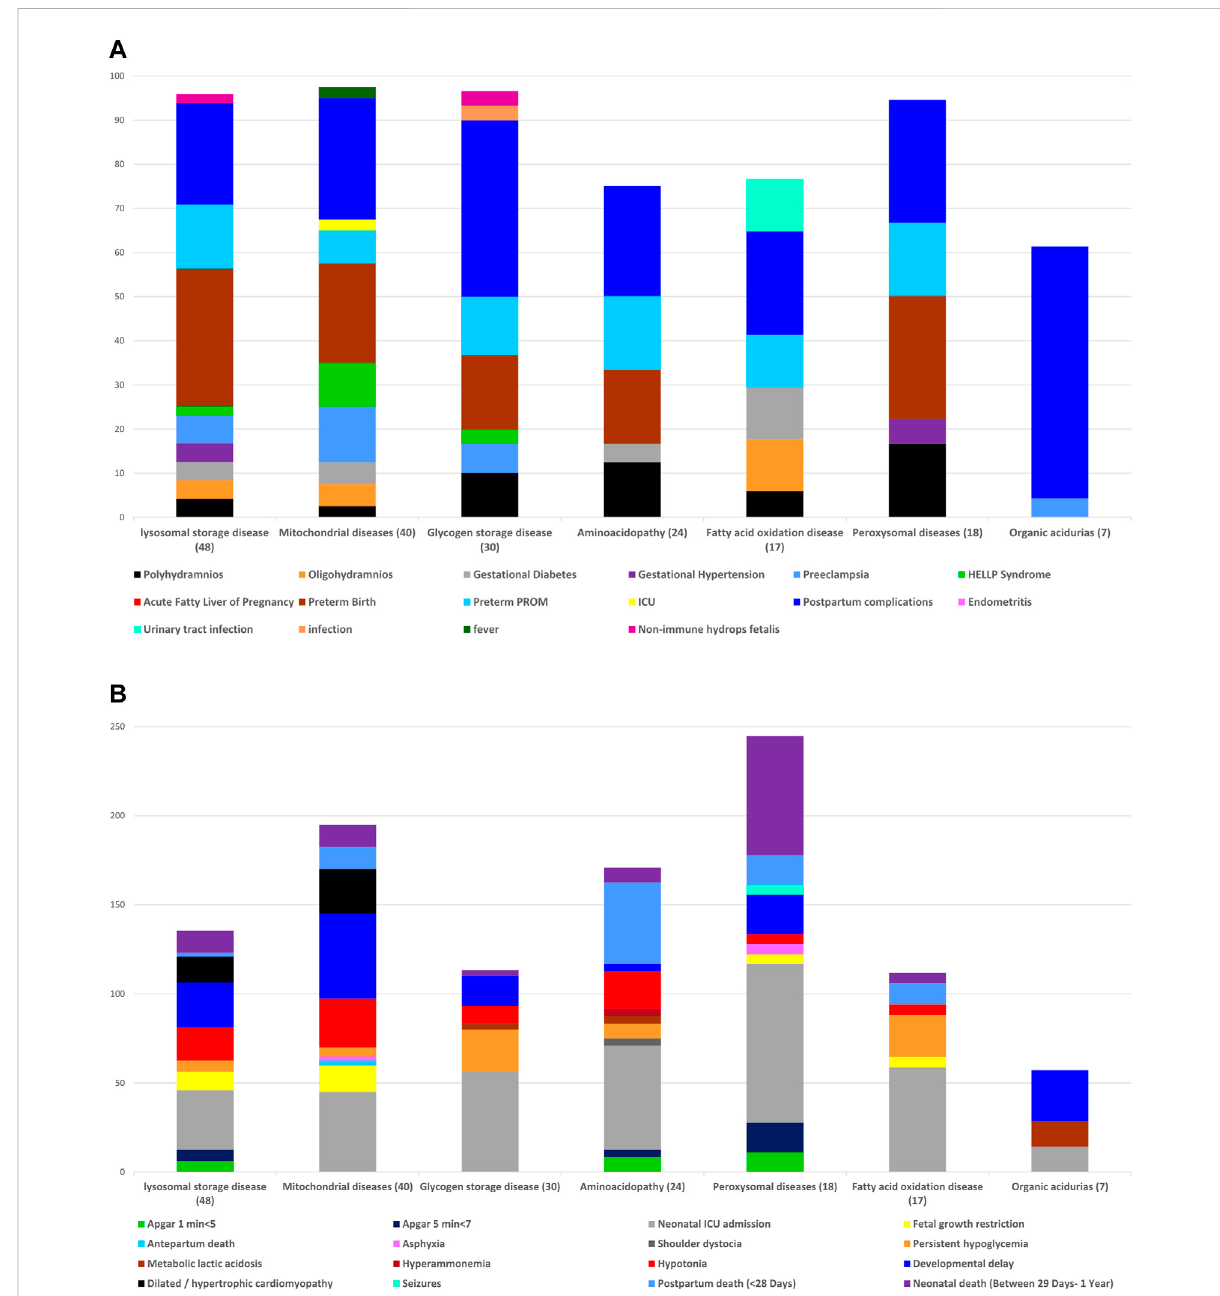
according to the types of inborn errors of